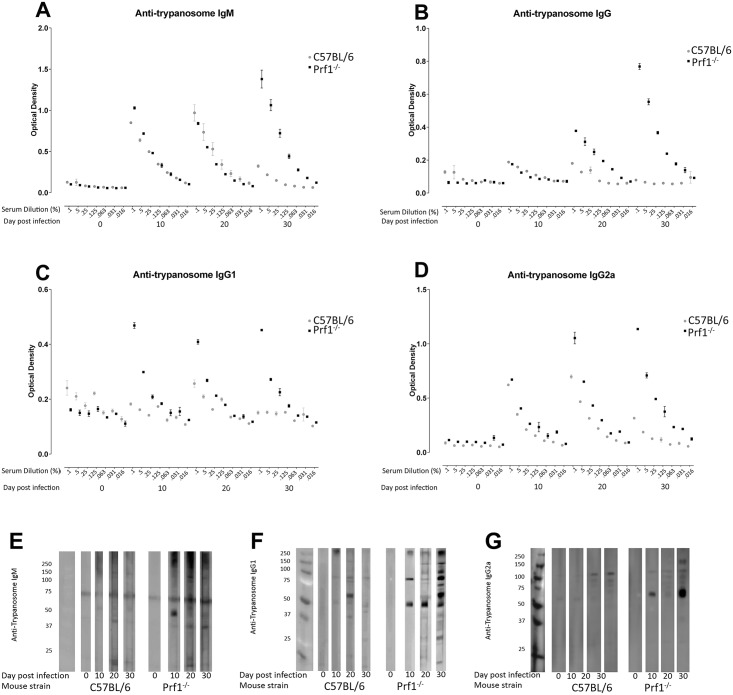
Analysis by ELISA and western blotting of trypanosome antigen specific antibodies in sera from intact and Prf1
-/- C57BL/6 mice infected for up to 30 days with T. brucei AnTat 1.1.
T. b. brucei AnTat 1.1 lysate (1 μg protein in 0.05% Np40/well) was coated on wells of an ELISA plate and used to detect trypanosome antigen specific antibodies of: (A) IgM, (B) IgG, (C) IgG1, (D) IgG2a classes in dilutions of serum (doubling dilutions from 1:1000 to 1:54,000) from groups of uninfected (naïve) intact C57BL/6 (gray dots) and Prf1
-/- C57BL/6 mice (black squares) and mice that had been infected for 10, 20 or 30 days with T. brucei AnTat 1.1(n = 6/group). Trypanosome lysate (0.5% NP40) was subjected to SDS-PAGE, transferred to membrane and stained with pooled serum from a group of uninfected intact or Prf1
-/- mice (n = 6), or mice infected with T. brucei AnTat 1.1 for 10, 20 or 30 days as indicated (n = 6/group) to detect polypeptide-specific antibodies of: (E) IgM, (F) IgG1 and (G) IgG2a classes. Results are representative of results obtained in individual mice of each group in 3 identical experiments.